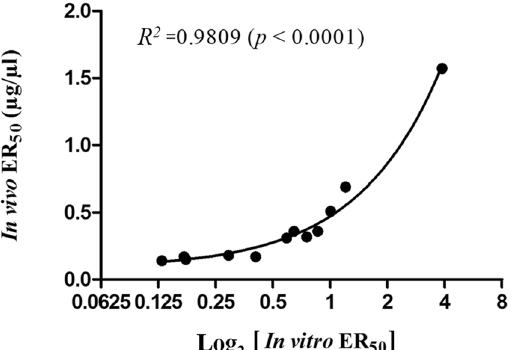
Figure 4. Regression between the nicotinic binding efficacy (Log 2 [ in vitro ER 50 ]) and the lethality neutralization efficacy ( in vivo ER 50 ). R 2 : Coefficient of determination. In vitro ER 50 values were expressed as mean ± S.D. ( μ g venom/ μ l antiserum) of 4 determinations. In vivo ER 50 values were expressed as median dose ± 95% C.I. from serial dose-response study in mice (n = 4–5 mice per dose). Footnote: For each batch of antiserum, the in vitro ER 50 was mean ± S.D. from 4 determinations while the in vivo ER 50 was median ± 95% C.I. (C.I. = confidence